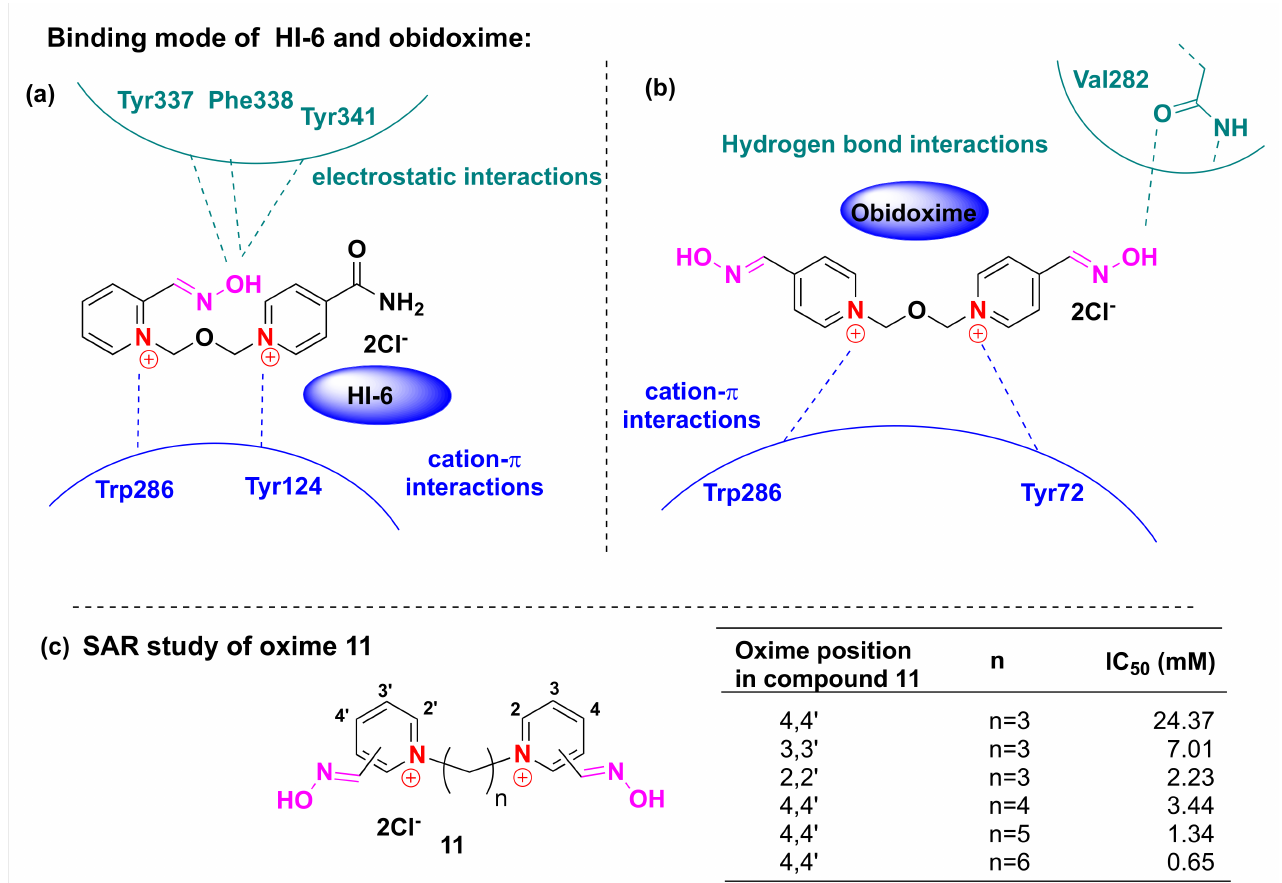
Figure 8. Binding modes of ( a ) HI-6, ( b ) obidoxime and ( c ) structure activity relationship (SAR) study based on oxime 11 dependence of IC 50 (half maximal inhibitory concentration) for the reactivators of the human recombinant AChE, PDB# 2GYW (stated are the positions of oxime groups in the pyridinium rings related to the nitrogen atom, number of carbon atoms in the linker and IC 50 of the reactivation of acetylcholinesterase using compounds 11